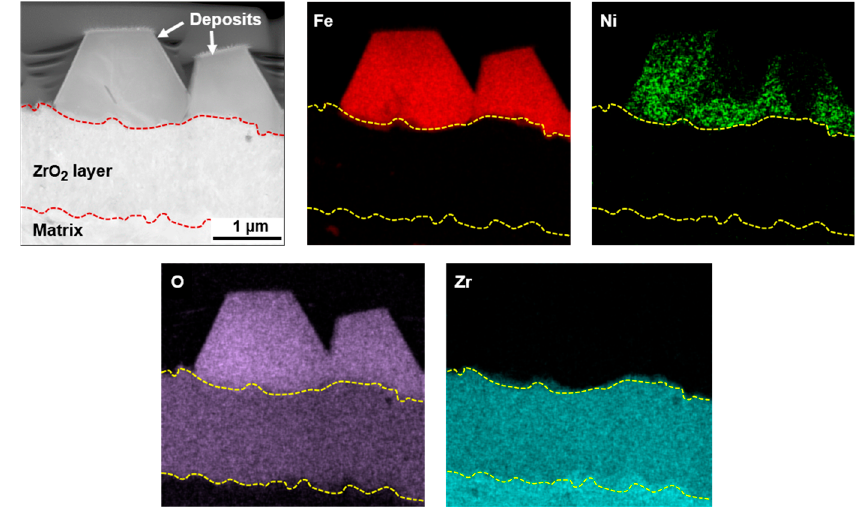
Figure 3. Scanning TEM (STEM) micrograph and elemental EDS maps of fuel deposits formed in the coolant without zinc (Case #1).